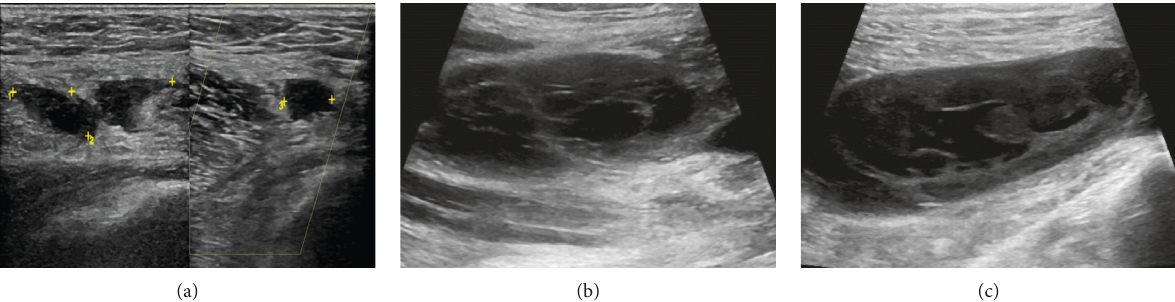
Figure 1: Ultrasound (US) of the left lower extremity: (a) Baker’s cyst. (b) Follow-up US showing the increased size of baker’s cyst. (c) Image depicting ruptured Baker’s cyst.